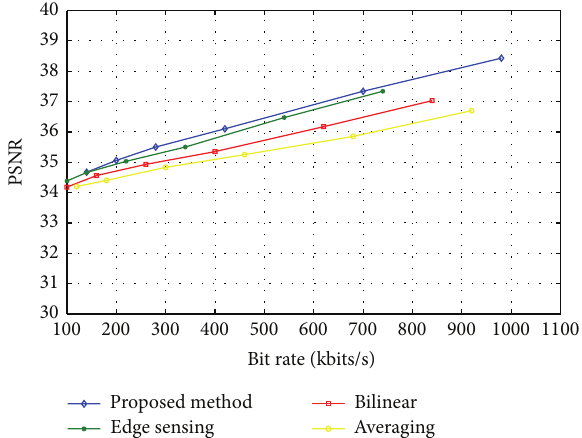
Figure 7: PSNR values at different bit-rates using interpolation and the proposed method (Foreman sequence) when one description is lost.